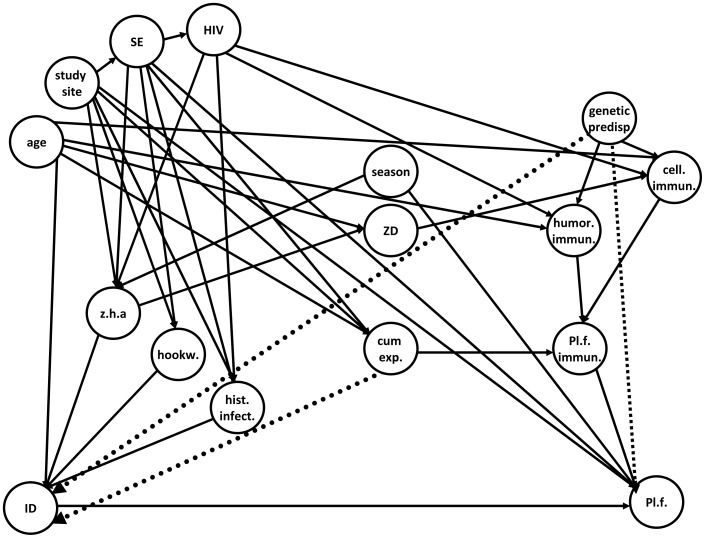
Directed acyclic graph for the relation between iron deficiency and malaria risk.cell. immun: cellular immunity; cum exp: cumulative malaria exposure; genetic predisp: genetic predisposition; humor immun: humoral immunity; hookw: hookworm infection; hist infect: history of other infections than malaria; HIV: human immunodeficiency virus; ID: iron deficiency; Pl.f.immun: immunity for Pl.falciparum; Pl.f: Plasmodium falciparum infection; SE: socio economic score; ZD: zinc deficiency; z.h.a: z-score height for age.